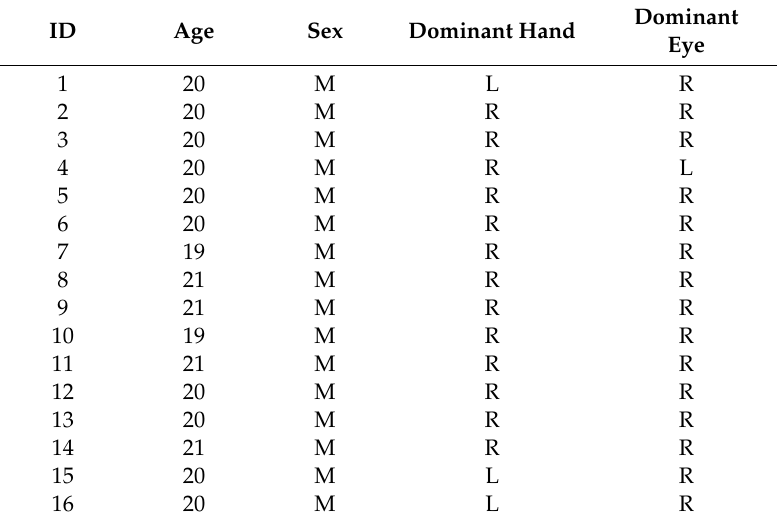
Table 1. Characteristics of 16